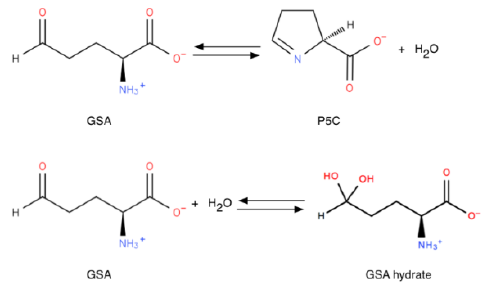
Figure 3. Cyclization and hydration of glutamate-5-semi-aldehyde (GSA). P5C: pyrroline-5-carboxylate.